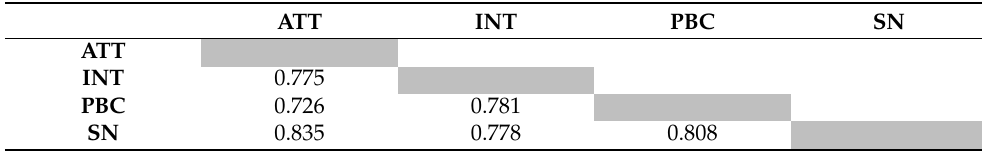
Table 2. Discriminant validity analysis.